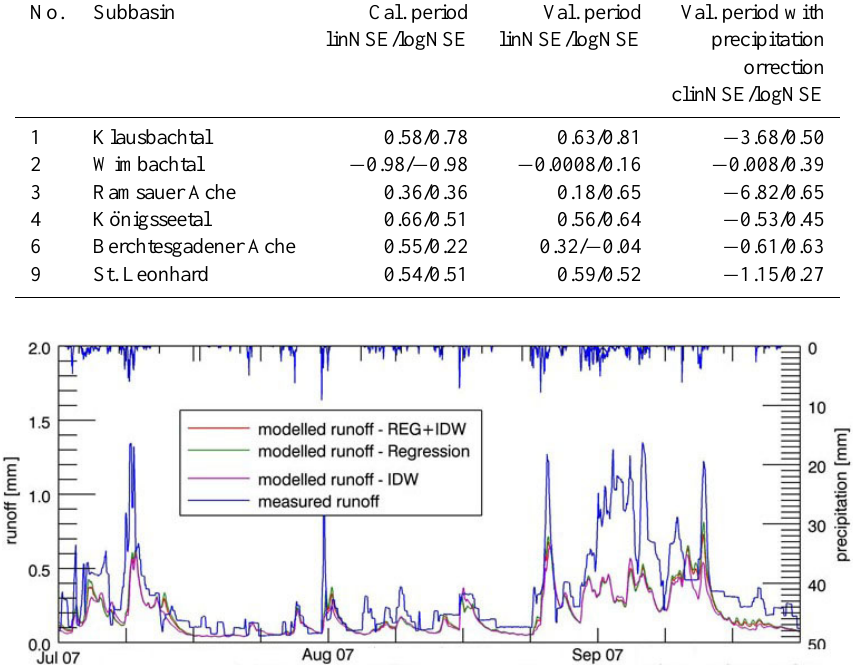
Fig. 5. Comparison of different interpolation methods in subbasin K¨onigsseetal. Inverse distance weighting (IDW), elevation dependent regression (REG) and both methods linearly combined